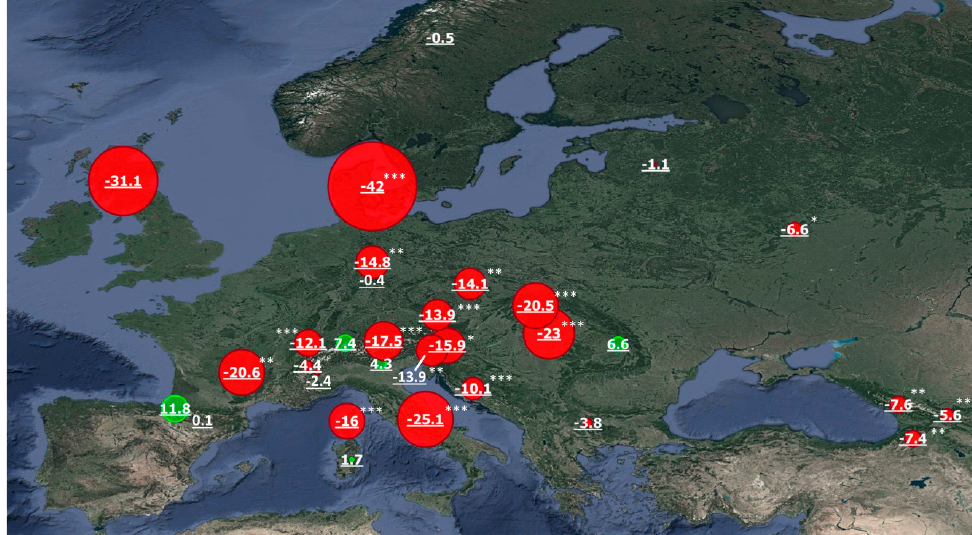
Figure 4. Changes (days) in SOS during the period 2001–2021. SOS advance is highlighted with red circles, whereas delay is highlighted with green circles. Sites that display a significant SOS-year correlation are marked with * (0.05 < F ≤ 0.1), ** (0.01 < F ≤ 0.05) and *** (F ≤ 0.01).